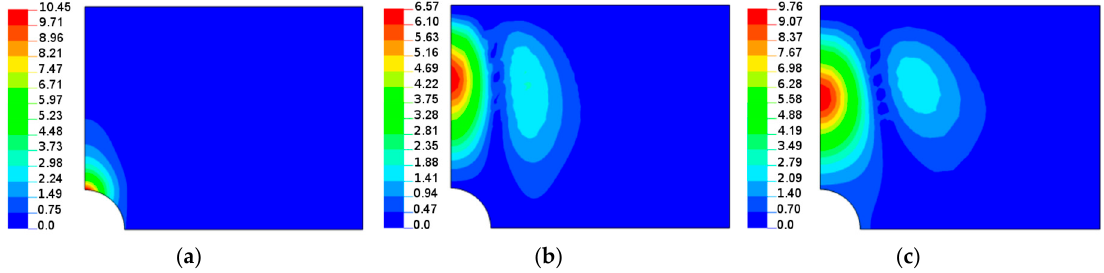
Figure 9. Buckling modes (normal deflections) for the rectangular plate, L x / L y = 1.25, with the circular hole 2 b / L x = 0.16: ( a ) isotropy E 1 / E 2 = 1; ( b ) E 1 / E 2 = 2 θ = 14°; ( c ) E 1 / E 2 = 2 θ = 30°.